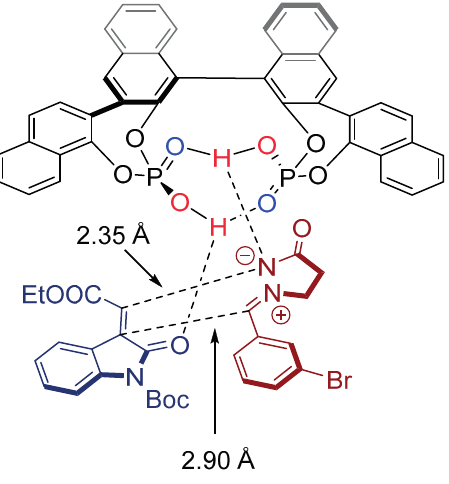
Figure 9. Transition state structure based on DFT calculations and MS